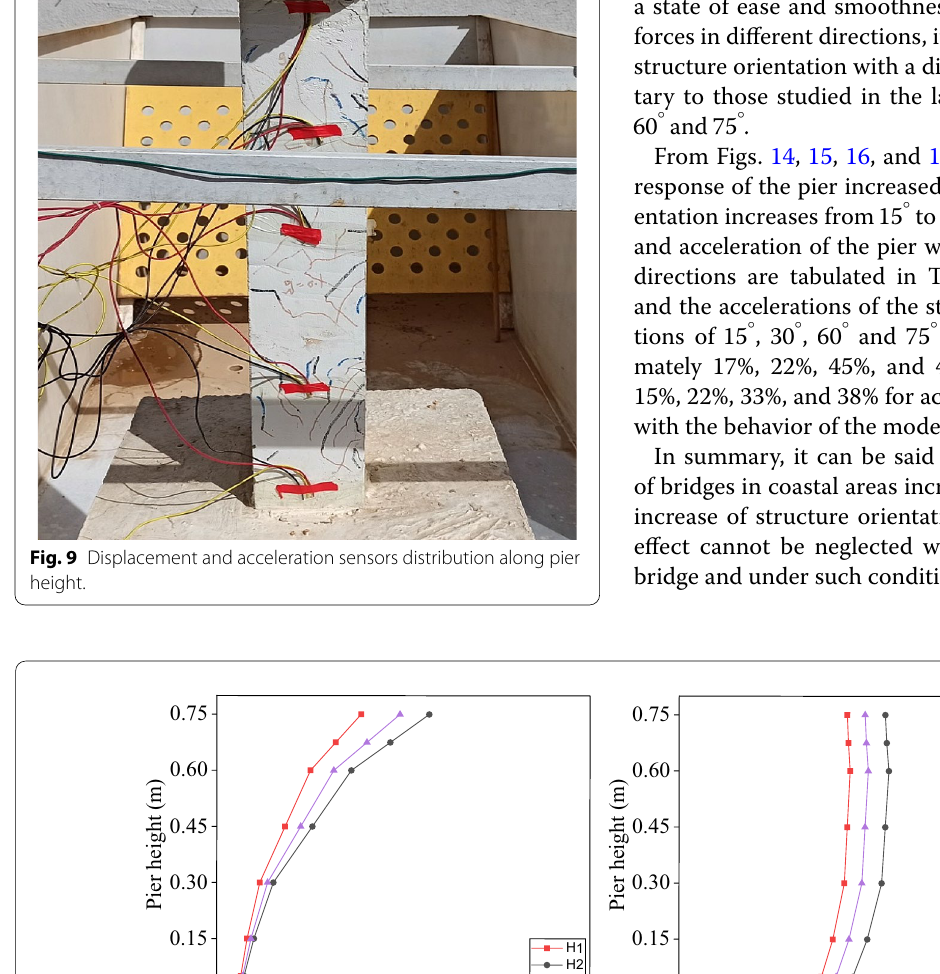
0 . Fig. 10 Peak relative displacement and peak acceleration of the pier under structure orientation ( 0 ◦ ) .